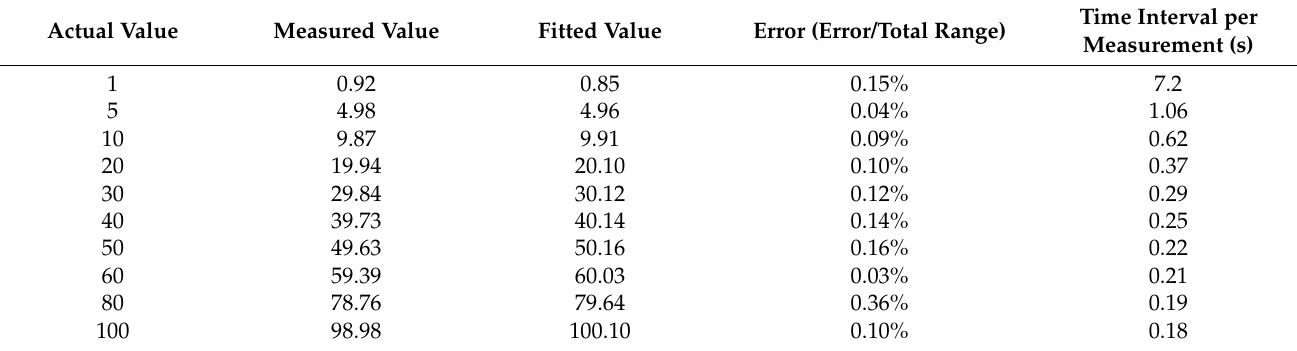
Table 2. Calculated primary side current (unit: A).